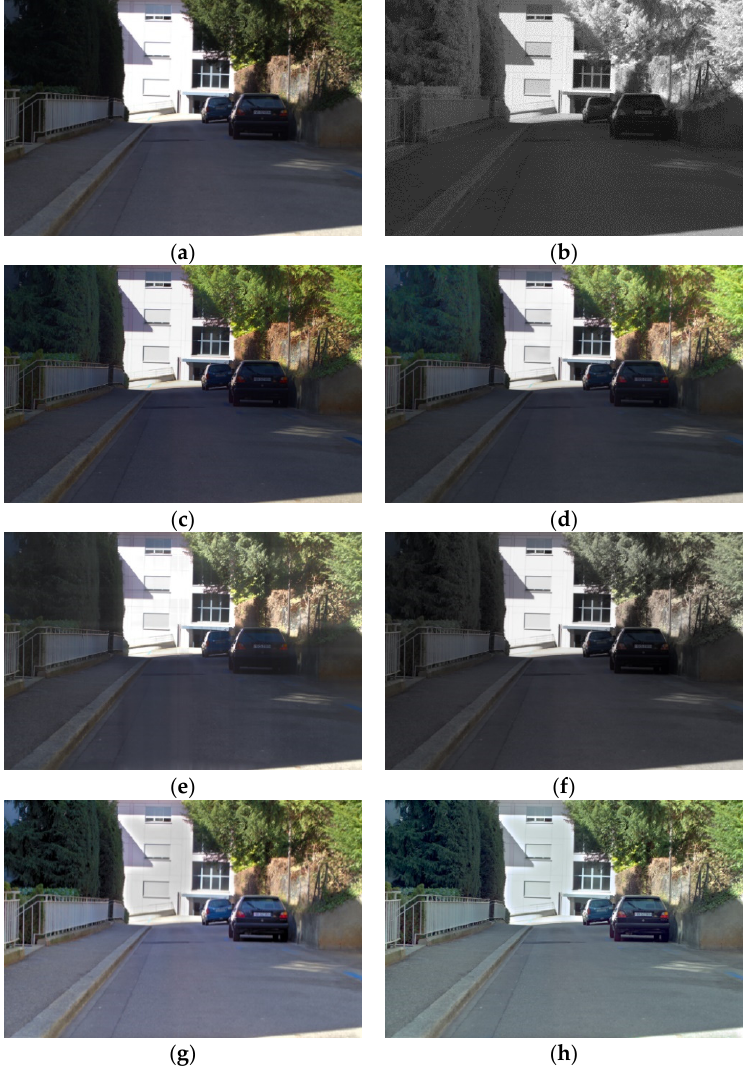
Figure 9. Input pair and result images: ( a ) visible image; ( b ) IR image; ( c ) Laplacian pyramid entropy fusion; ( d ) Laplacian pyramid PCA fusion; ( e ) low-rank fusion; ( f ) dense fusion; ( g ) proposed method (luminance channel fusion); and ( h ) proposed method (XYZ channel fusion). In Figure 9, the tone and detail of the shaded area have been improved, allowing identification of the license plate number. In Figure 10, the low-level tone generated by backlighting was improved (rock area), and the detail of the distant part by the NIR image and the advantages of the water transmission performance by the visible image were well expressed. Therefore, the characteristics of visible and NIR images are well combined and expressed. In Figure 11, the contrast ratio between the luminance of the dark part inside the alley and the luminance of the sky with strong external light was well compressed, greatly improving the object expression performance of the entire image. In Figure 12, it